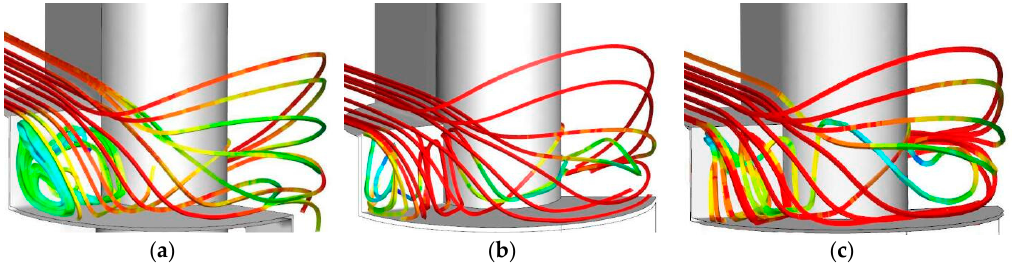
Figure 5. Streamlines above the S2 in different configurations: ( a ) 120°; ( b ) 150°; and ( c ) 180°.